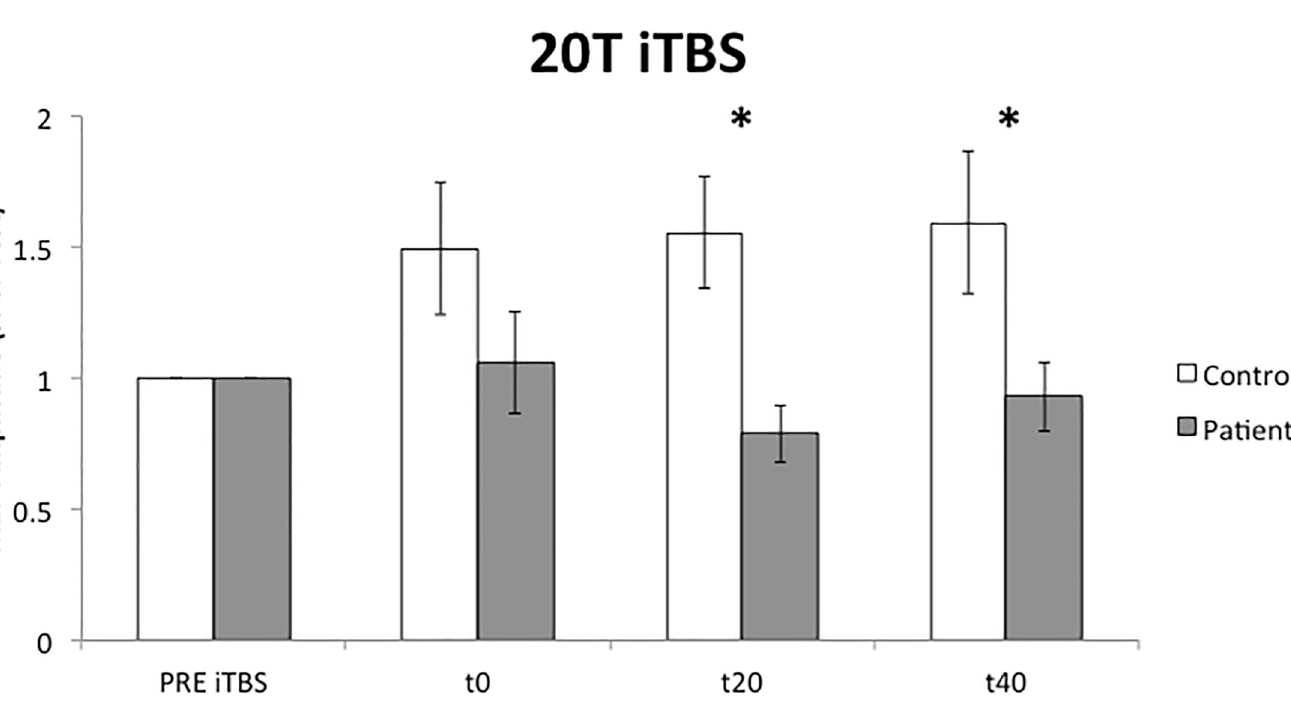
PLOS ONE | https://doi.org/10.1371/journal.pone.0211367 January 25,